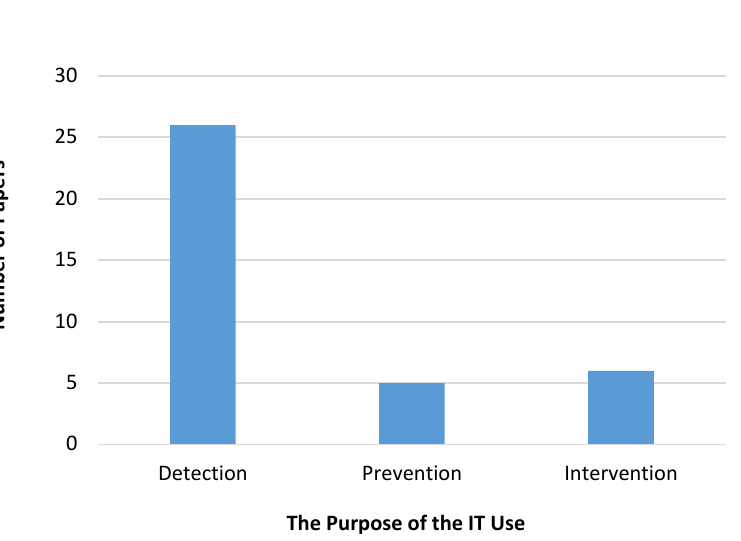
Figure 5. The number of studies in each purpose.